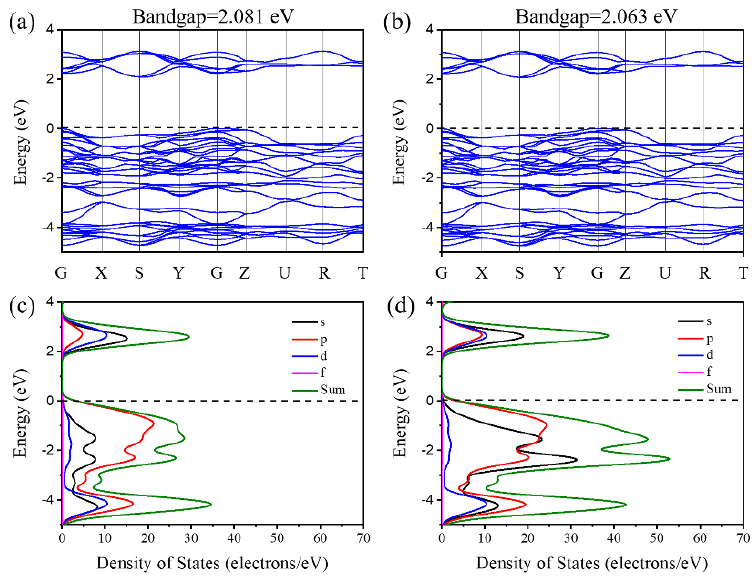
Figure 2. The calculated energy band structure of Sm25Na00 ( a ) and Sm25Na25 ( b ). Density of states of Sm25Na00 ( c ) and Sm25Na25 ( d ) near the Fermi energy level (the Fermi energy is the zero of the energy scale).